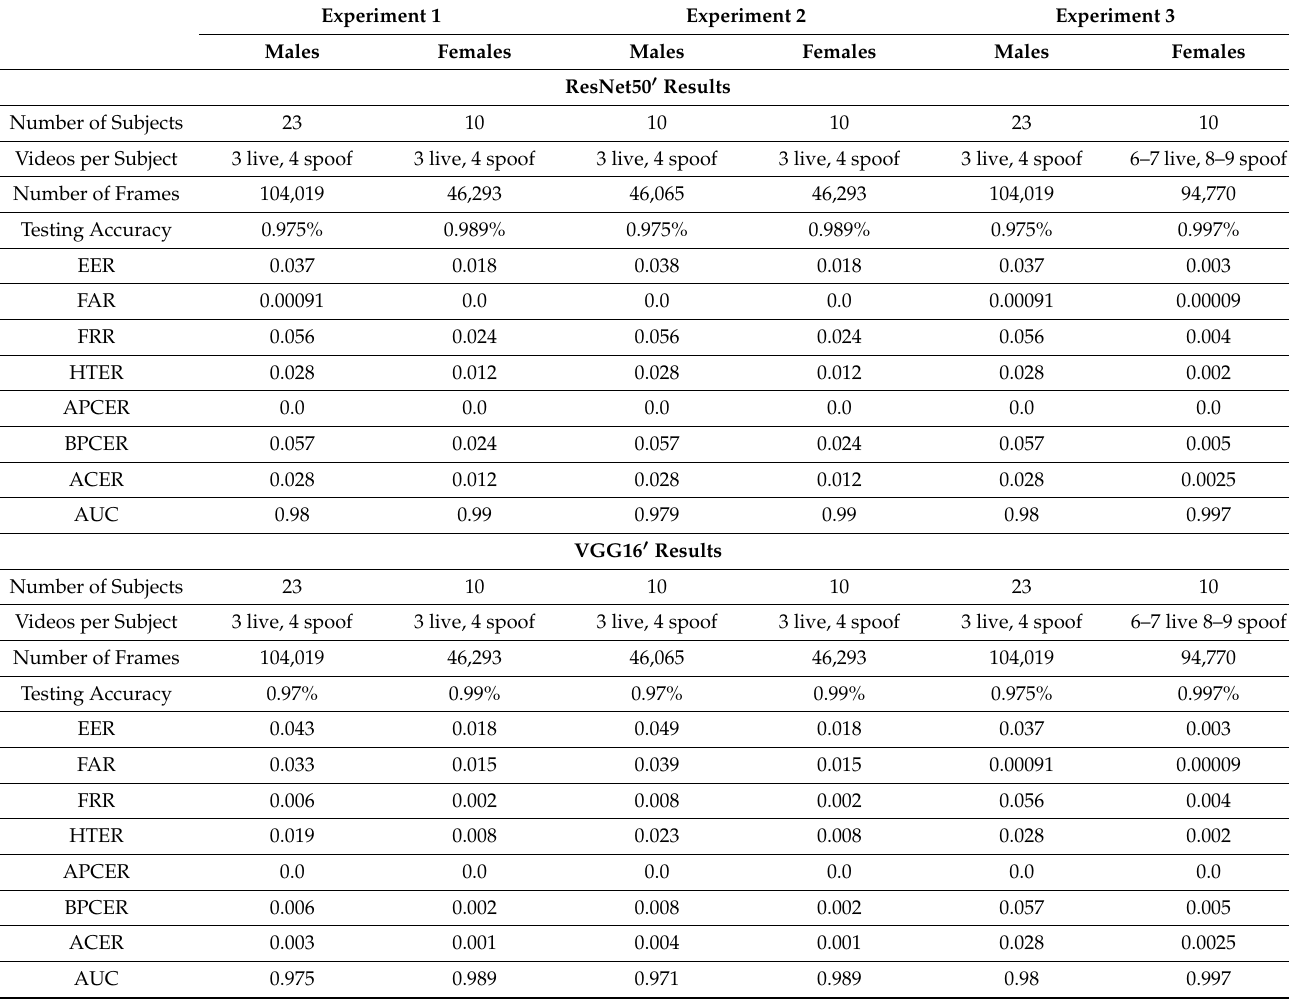
Table 5. Results for experiments in phase